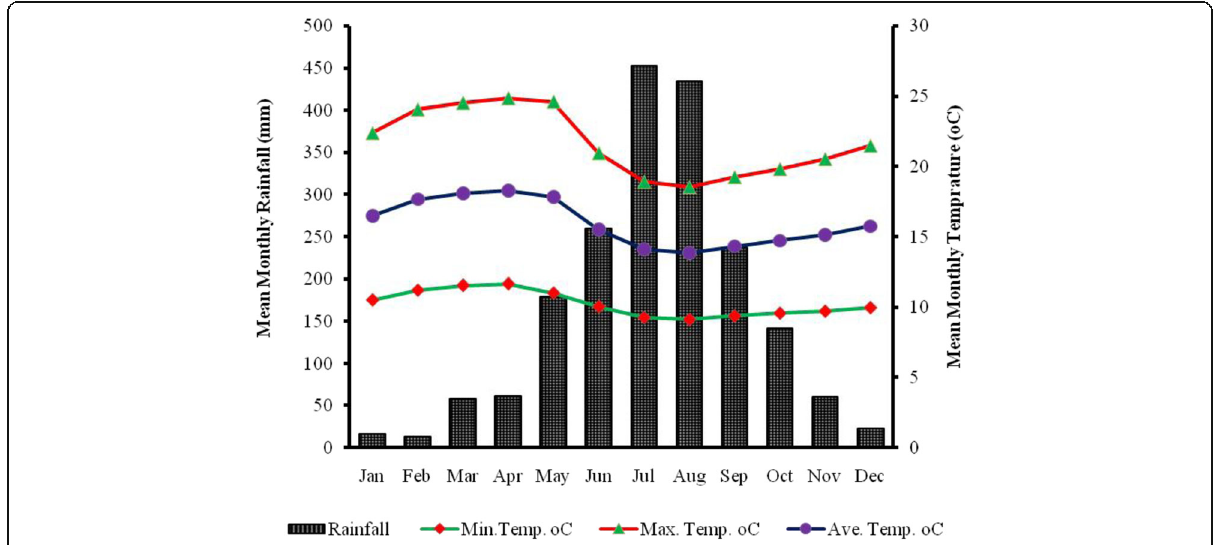
Fig. 2 Monthly average rainfall (mm) and temperature (maximum, minimum, and average) (°C) for the study area